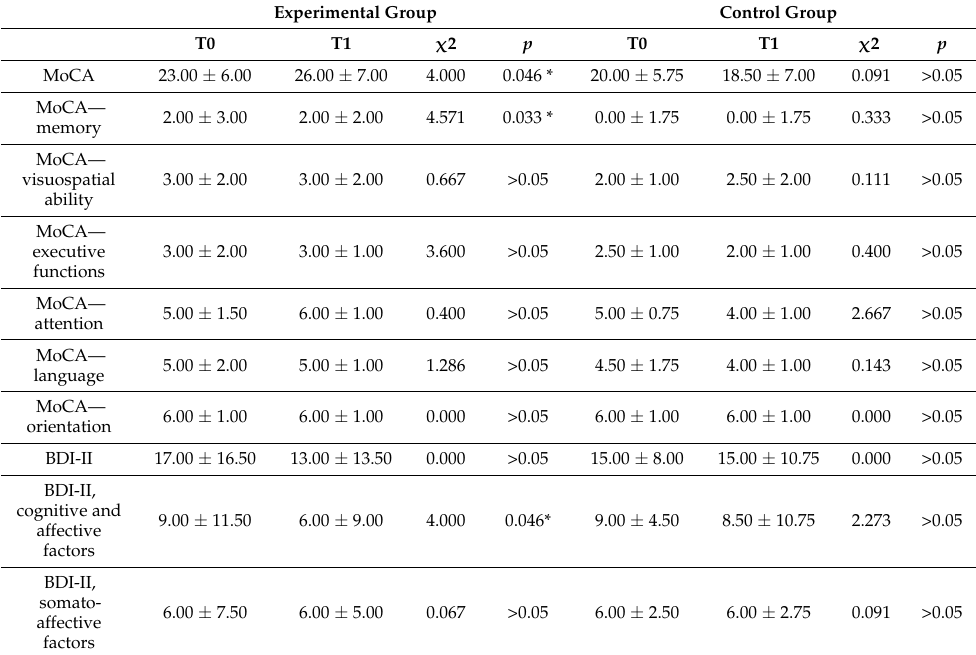
Table 2. Neuropsychological assessment results per group over time.